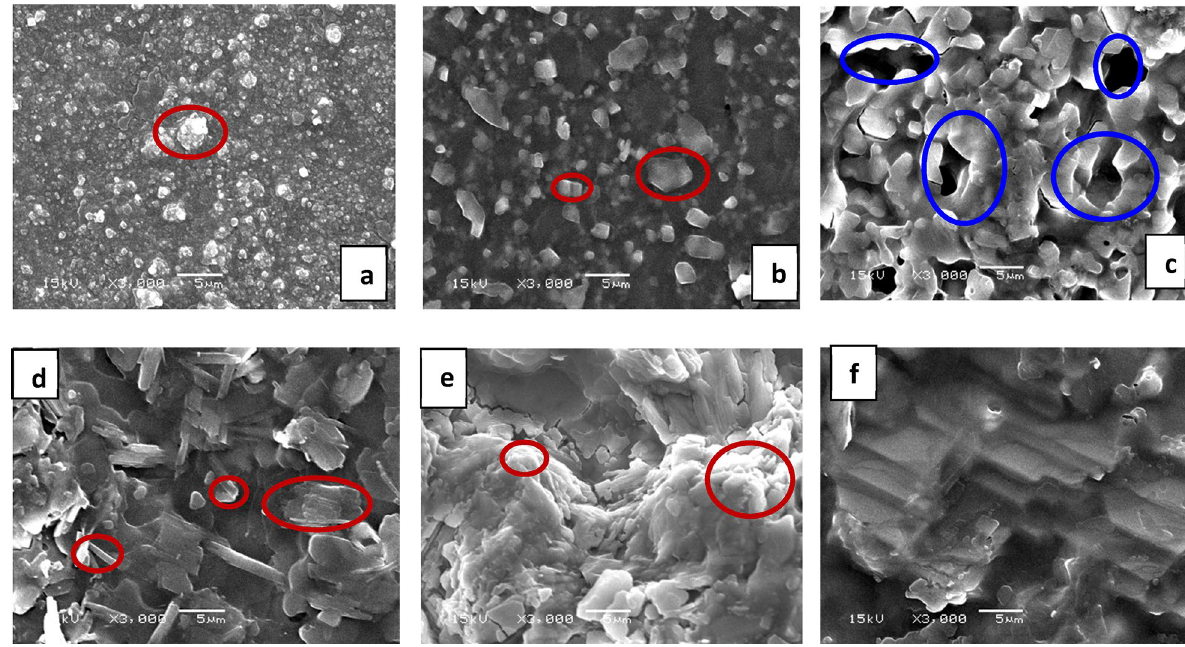
Figure 4. SEM images of ( a ) pure Ppy 1% -DBSA 2% /GS, ( b ) Ppy 1% -DBSA 2% /NiO 97% -GS@2, ( c ) Ppy 1% -DBSA 2% / NiO 97%